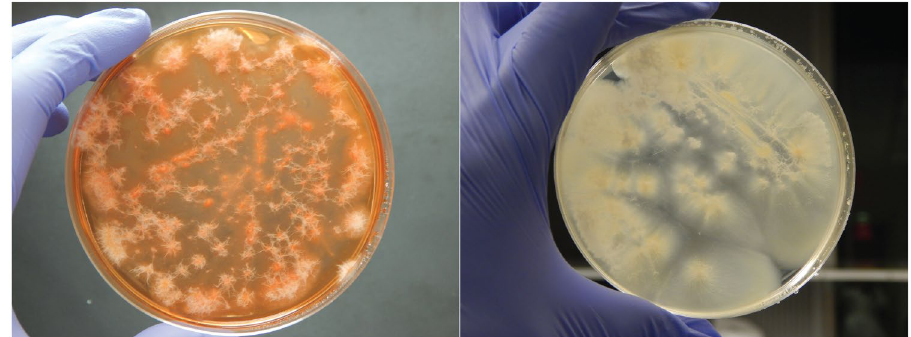
Figure 7. Comparison of cultures involving Coniochaeta sp. FLe4 in presence and absence of amphotericin B. Coniochaeta sp. FLe4 cultured in amphotericin B-enriched ISP-2 medium at 2 µ M (left) and in absence of amphotericin B, cultured only in ISP-2 medium (right). Photos were taken after six days of culture. For experimental details, see description for isolation of compound 29 in Materials and Methods section.